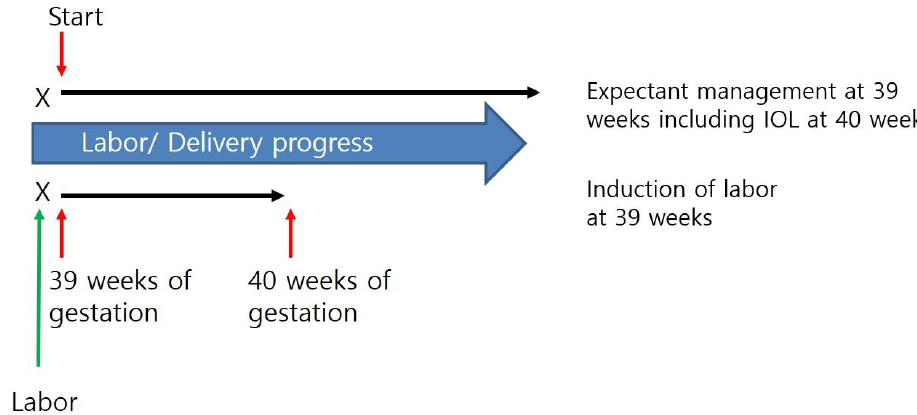
Figure 1. Diagram of study design. IOL, induction of labor .